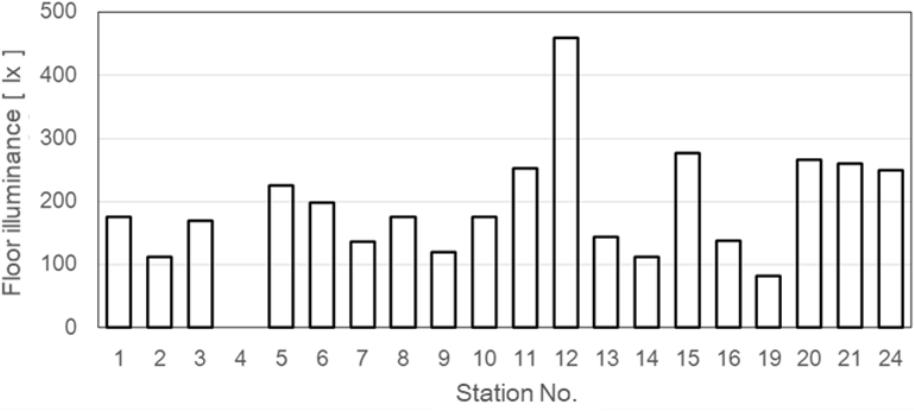
Figure 2. Floor illuminance measurement result at the entrance of stairs.